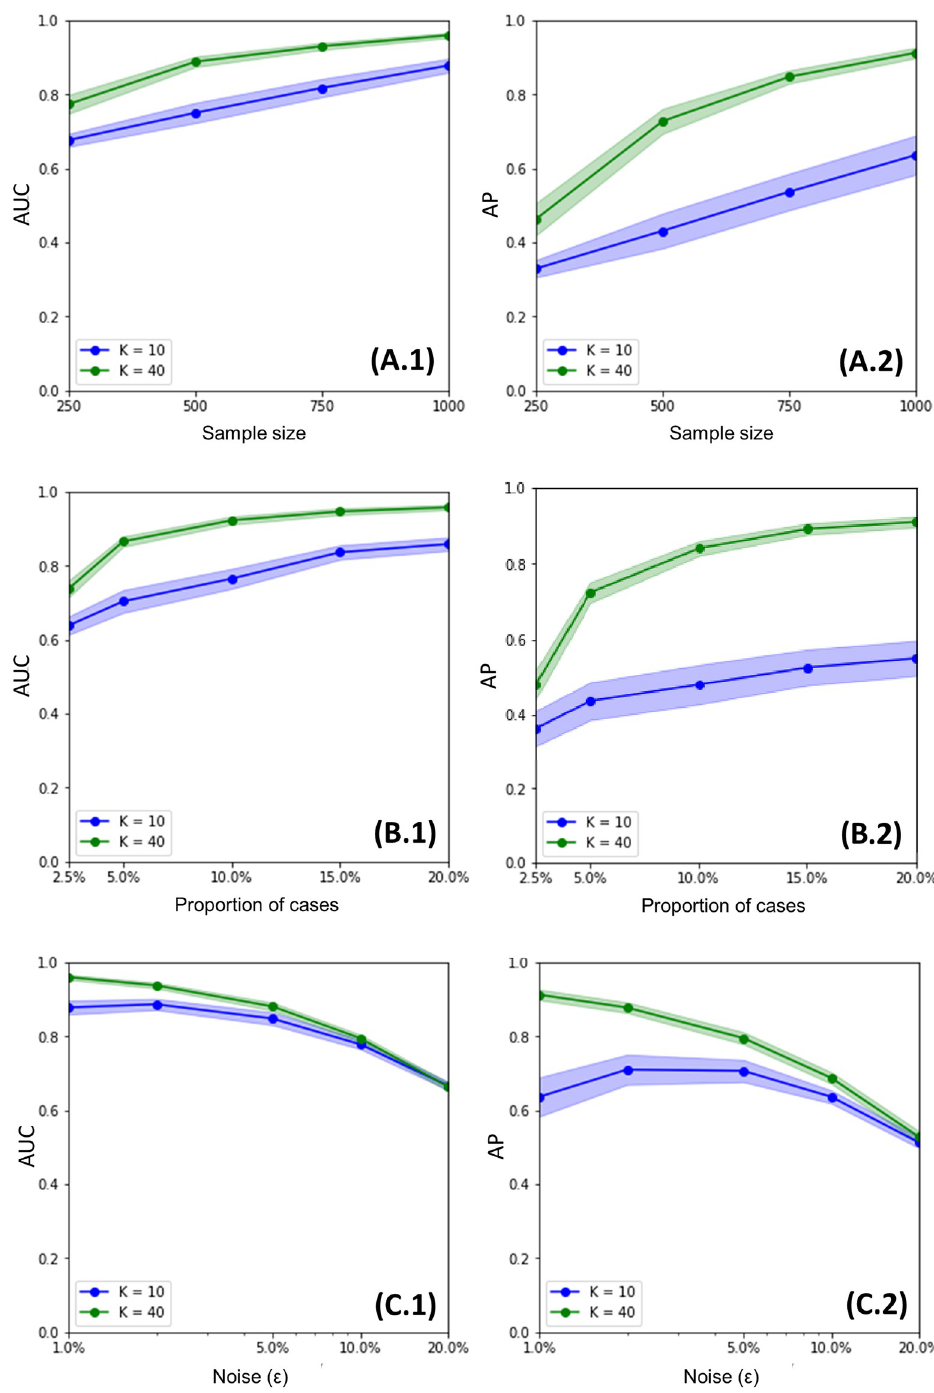
Fig 6. Sensitivity analysis results. Average performance of hi PRS in terms of AUC and AP for variable sample size (A.1 and A.2), class imbalance (B.1 and B.2) and missing heritability, i.e. noise (C.1 and C.2). Confidence bands are at the 95% level. The x -axis is in logarithmic scale for panels C.1 and C.2.